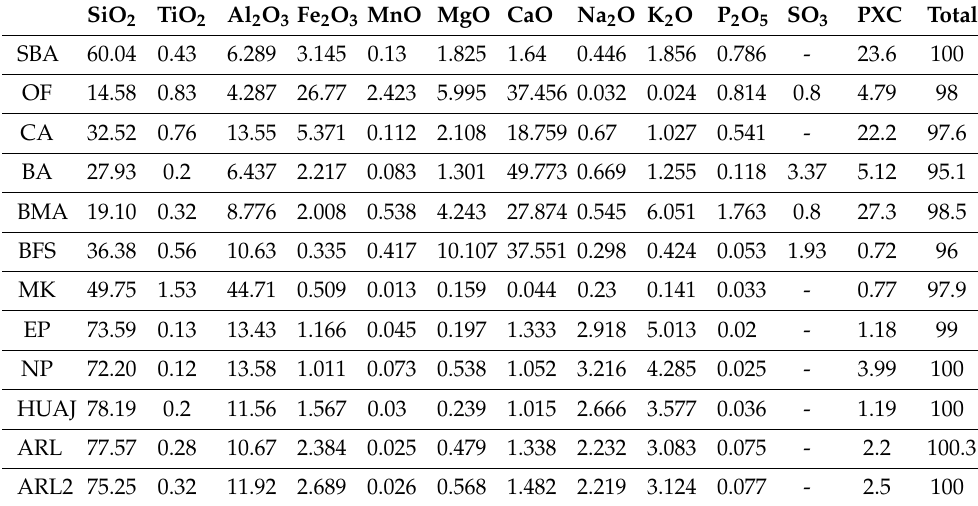
Figure 7. SEM microscopy images of the substitution materials. ( a ) PE; ( b ) NP; ( c ) MK; ( d ) OF; ( e ) C1; ( f ) C2. Table 3. EDS XRF results of the chemical composition of the